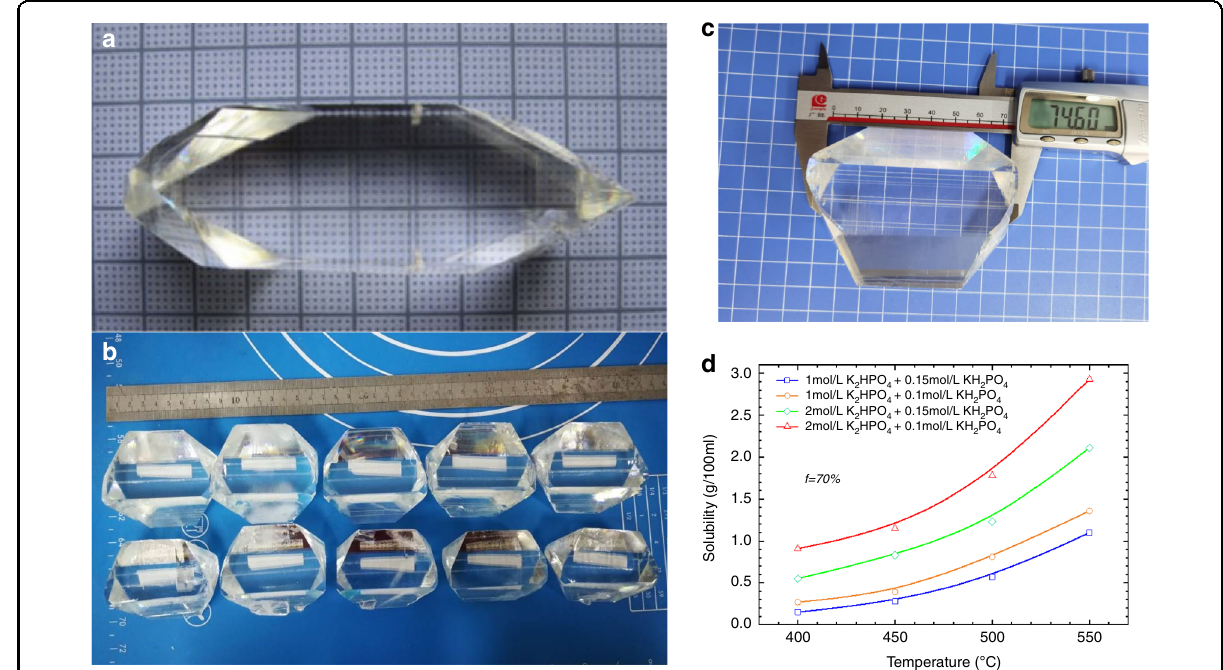
Fig. 7 As-grown KTP crystal by hydrothermal method and solubility-temperature curve. As-grown KTP crystal in one autoclave a with Φ 60 mm inner diameter; b , c with Φ 90 mm inner diameter in a cycle of growth. d Solubility-temperature curve for KTP in K 2 HPO 4 and KH 2 PO 4 mixed solution in the range from 400 to 550